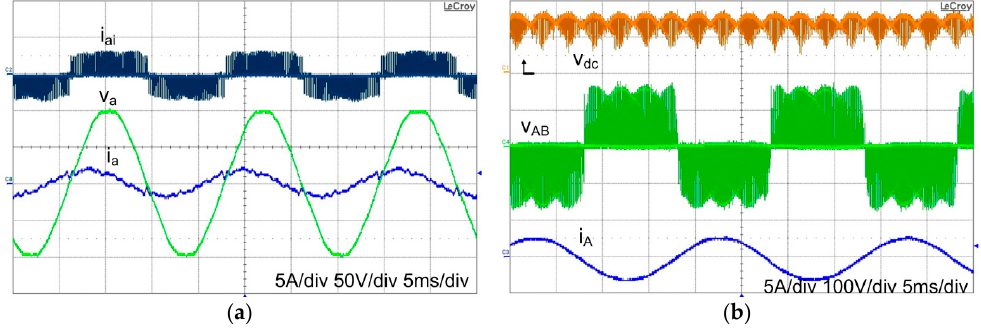
Figure 15. ( a ) Input waveforms; and ( b ) DC-link voltage and output waveforms with the conventional method at m = 0.35 and f out = 50 Hz (PF = 0.71).